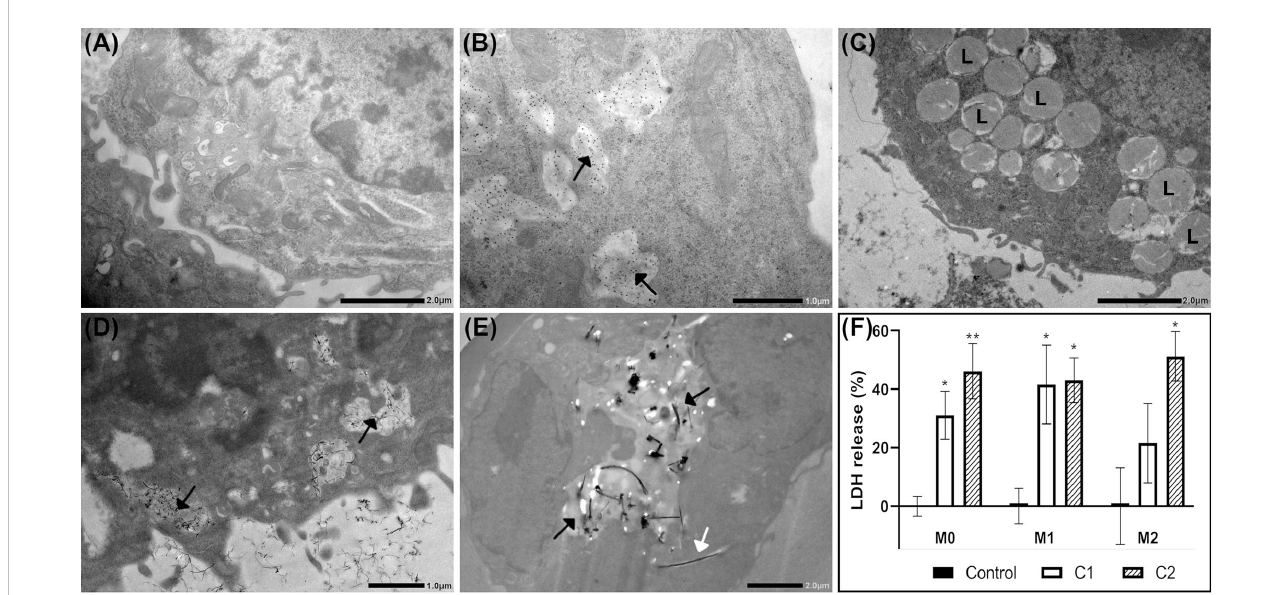
FIGURE 2 Cellular uptake and effects on membrane permeability at 24h post-exposure. Uptake of nanomaterials was investigated by TEM or immuno-TEM in M1 macrophages. Representative images of (A) Control, (B) CNC, (C) CNF, (D) NM-400, and (E) NM-401-exposed cells. C1: 0.15 m g/cm 2 and C2: 2.7 m g/cm 2 . The experiment was repeated twice. Black arrows indicate endosomal structures with nanomaterials. White arrows indicate fi bers in cell cytoplasm. L indicates lysosomal structures. (F) Membrane leakage as measured by medium lactate dehydrogenase (LDH) release following NM-401 exposure. Data indicate mean ± SD, (n=3-5), *p<0.05,